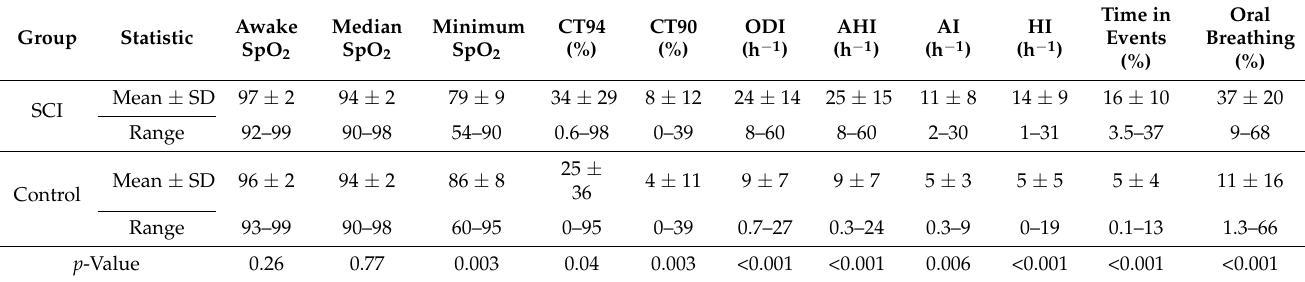
Table 3. Group means, standard deviations, and ranges for each variable for the SCI and control